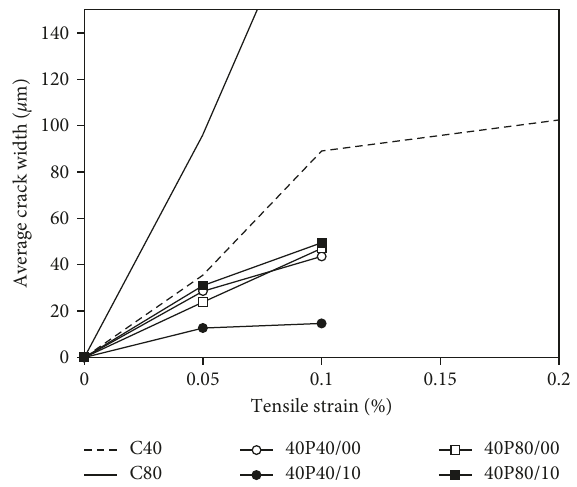
Figure 5: Average crack widths in lap splice for the specimens with 40% l d